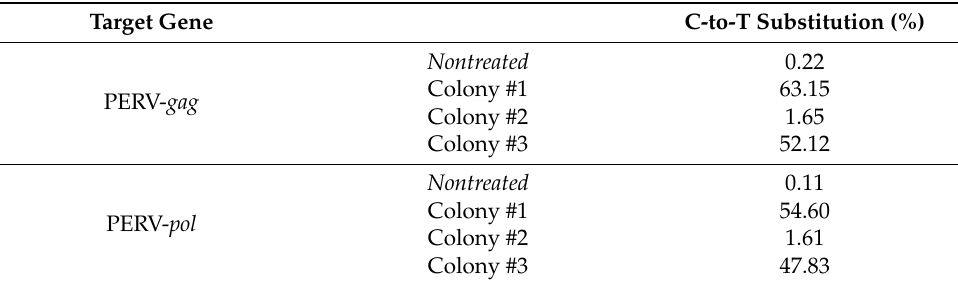
Table 3. C-to-T substitution mediated by the Target-AID system in porcine